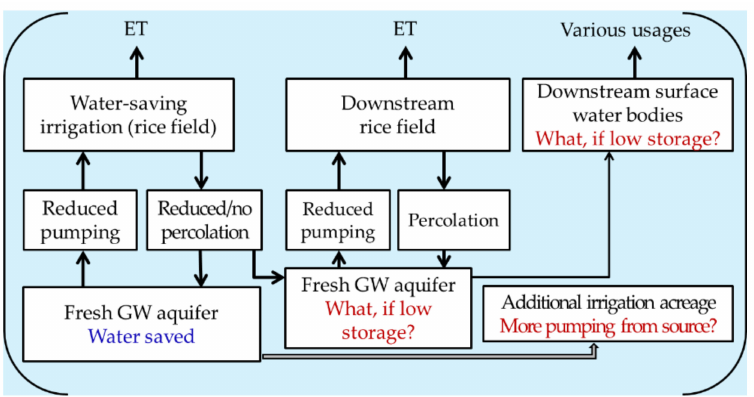
Figure 4. Conceptualizing of impacts of water-saving measures on regional surface and groundwater sources when irrigation uses